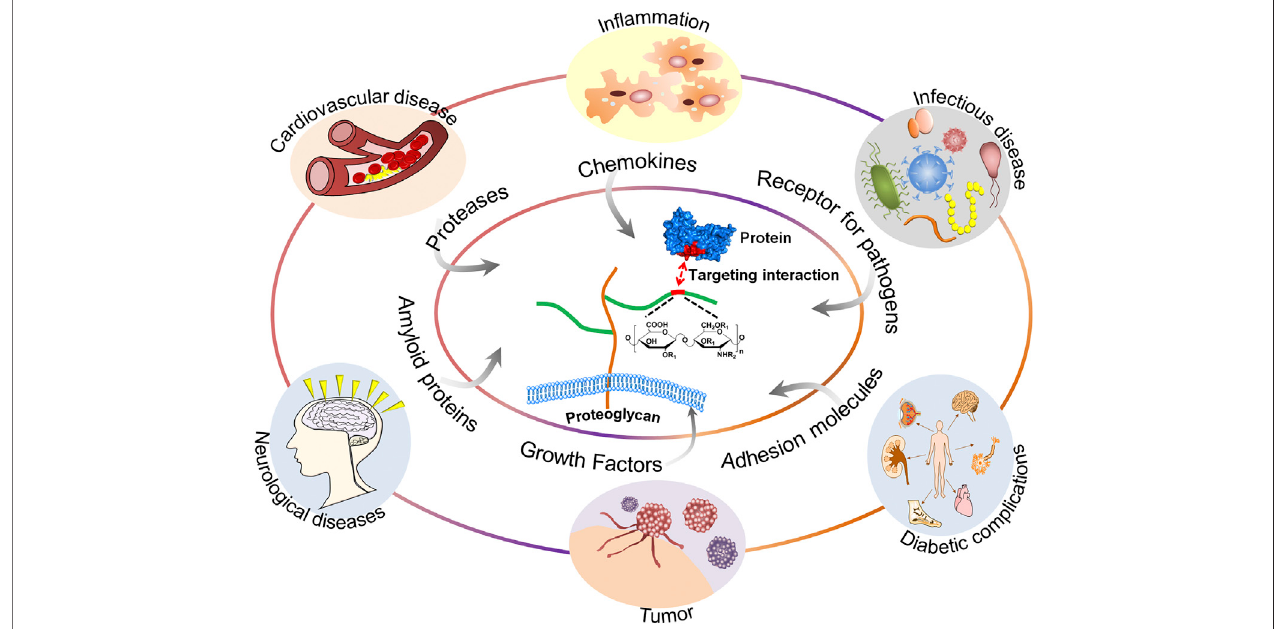
FIGURE 1 | A schematic representation of the structure of GAGs and their interactions with proteins and functions relevant to speci fi c